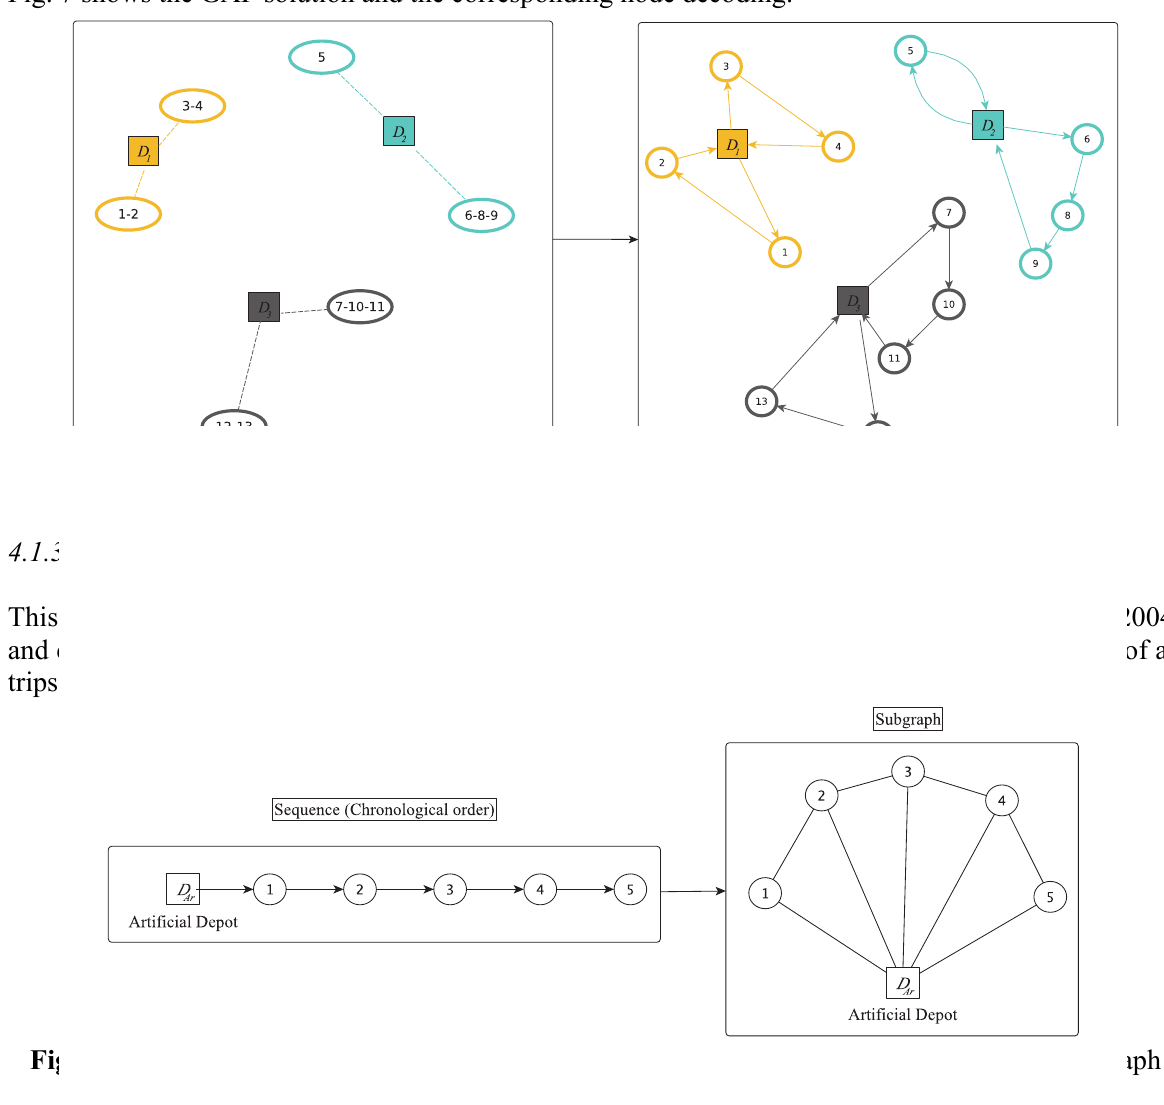
Fig. 8. Ascending ordered sequence (or any combination of criteria) and its corresponding